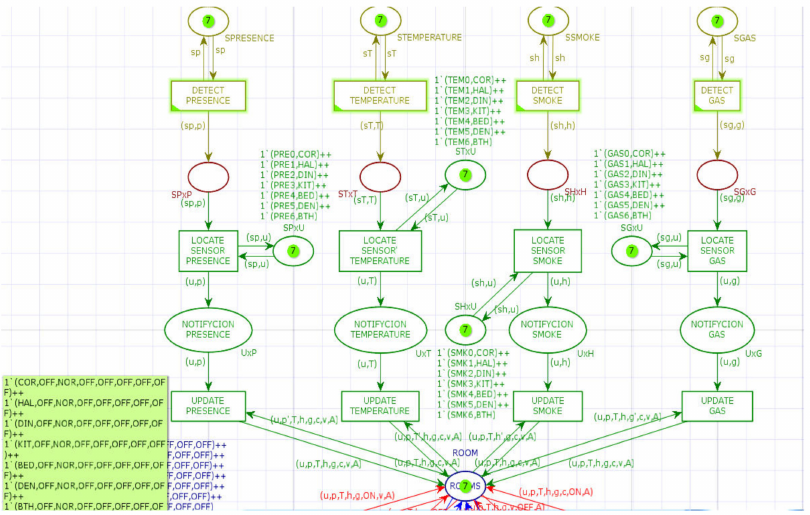
Figure 6. CPN of the update service for the case